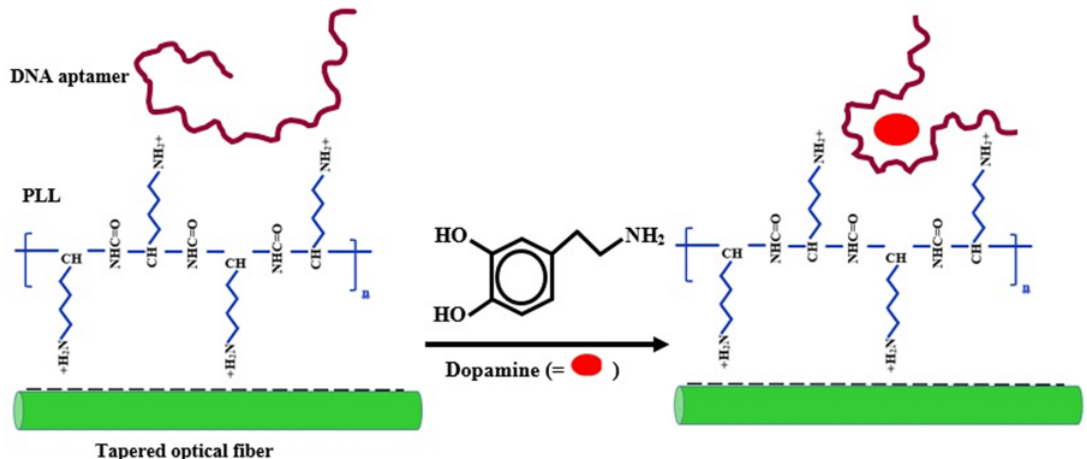
Figure 2. Schematic representation of the fiber optic and aptamer based dopamine detection